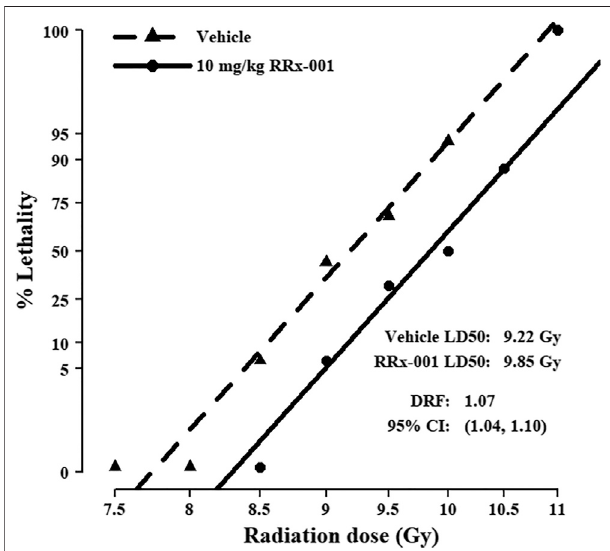
FIGURE 2 | Probit mortality curves for 192 mice equally randomized to prophylactic treatment with 10 mg/kg RRx-001 or vehicle control; mice were further equally randomized among the six indicated TBI doses to determine the DRF ( n (cid:1) 16 mice/group). LD 50/30 and DRF were estimated with probitregressionofmortalityonlog 10 doseofradiation.TheLD 50/30 forvehicle pre-treated mice was 9.22 (95% CI: 9.03, 9.41), and for RRx-001 pre-treated mice was 9.85 (95% CI: 9.66, 10.05); thus, the DRF was 1.07 (95% CI: 1.04, 1.10). The common slope was 39.6 (95% CI: 29.8, 49.4).